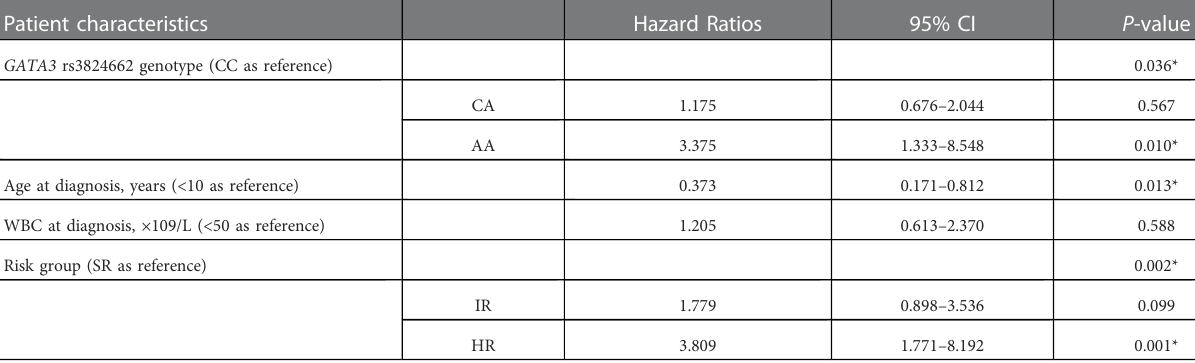
TABLE 5 Multivariable analysis of GATA3 rs3824662 genotype for association with sepsis risk. Patient